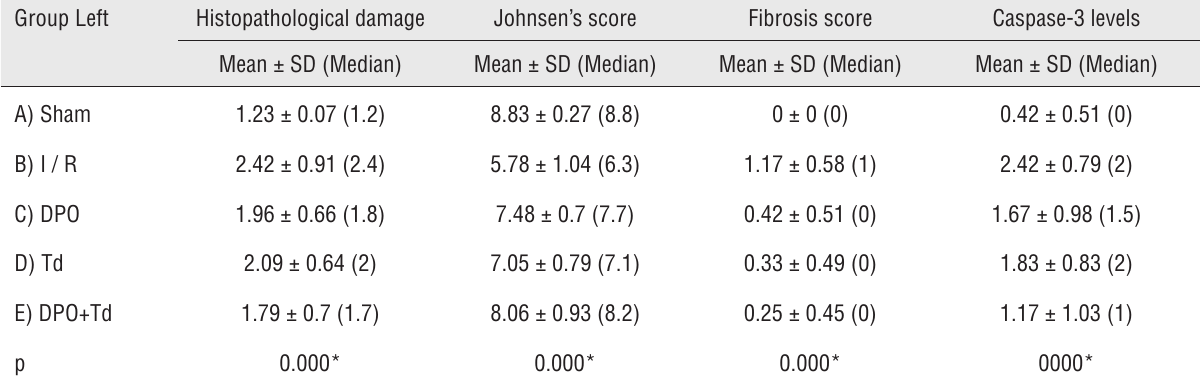
Table 1 (A and B) - Analysis of study parameters in the left then in the right testis between groups. Table A Group Left